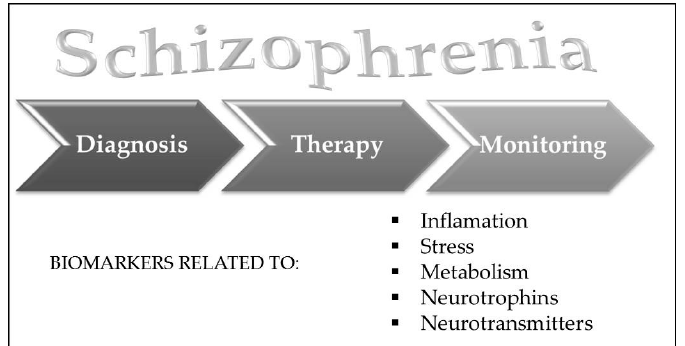
Figure 2. Diagnostic, prognostic and theranostic biomarkers for schizophrenia might be divided into inflammatory, stress-related, metabolic, neurotrophic and neurotransmitter biomarkers.